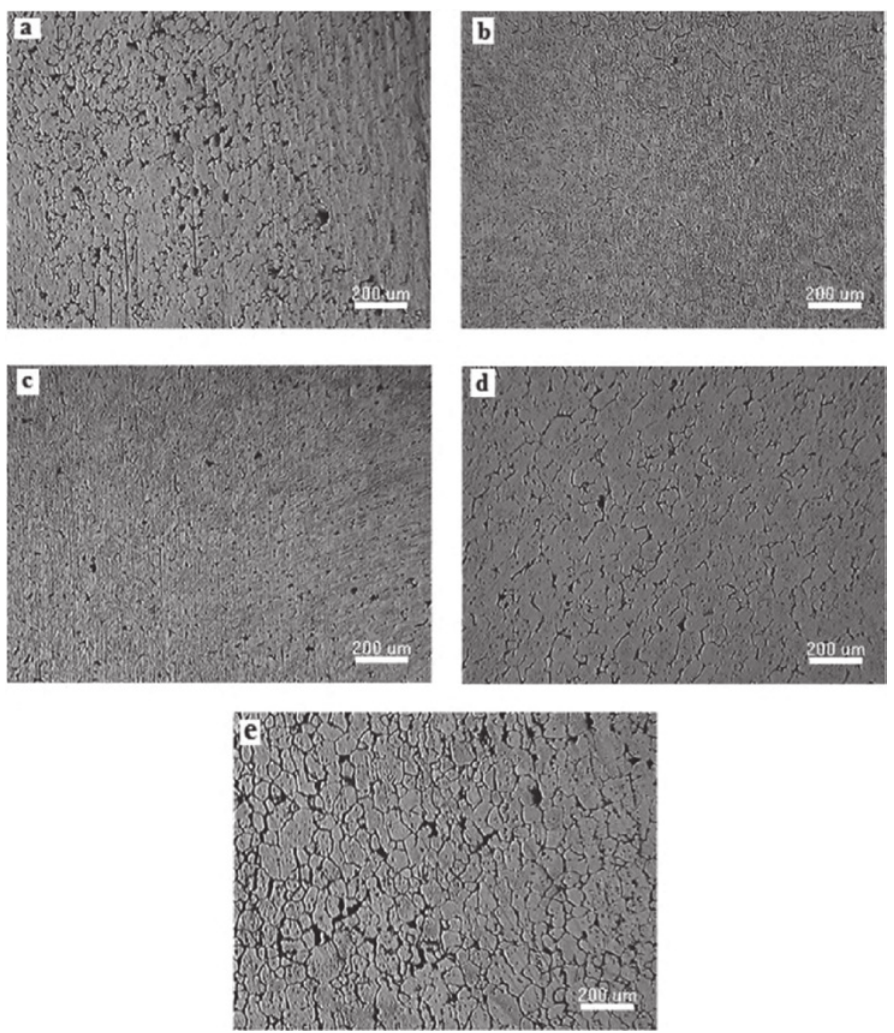
Fig. 2: Optical micrograph of AA7075; ECAP 1 passed + Thixoformed (a), ECAP 2 passed + Thixoformed (b), ECAP 3 passed + Thixoformed (c), ECAP 4 passed + Thixoformed (d), Thixoformed